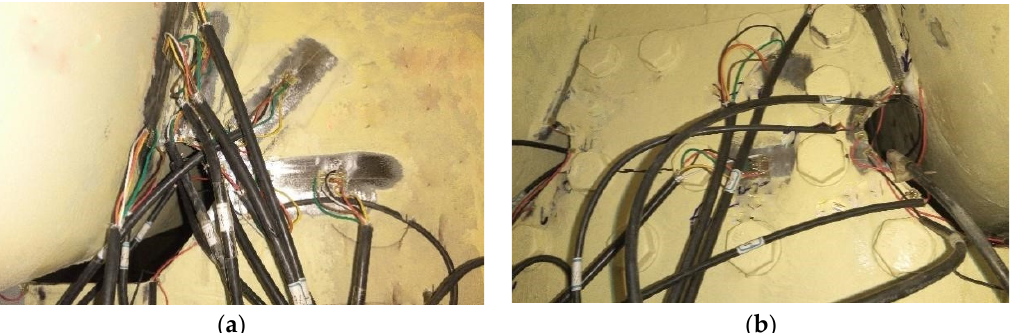
Figure 12. A partially enlarged view of the strain measuring point on the side of the diaphragm: ( a ) Unoptimized measuring point, ( b ) measure point after optimization of the arc-shaped